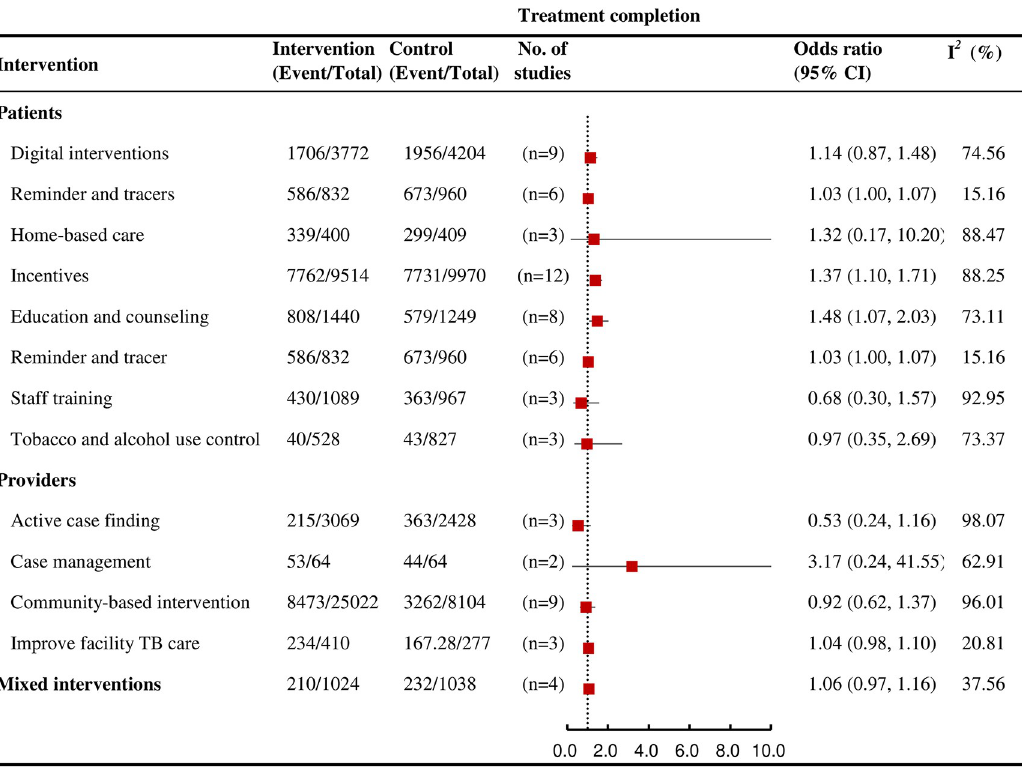
Fig 7. Forest plots showing the effects of various interventions on TB treatment completion outcomes for active TB.